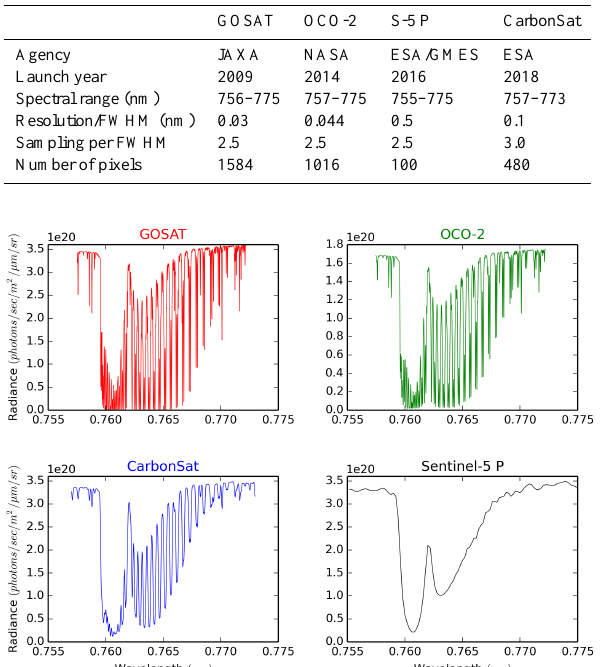
Table 1. Assumed instrument parameters in the O 2 A-band range for the four instruments used in this study. Resolution is defined by the FWHM of an assumed Gaussian distribution for OCO-2, Car- bonSat and S-5 P. GOSAT is as in Kuze et al. (2009).